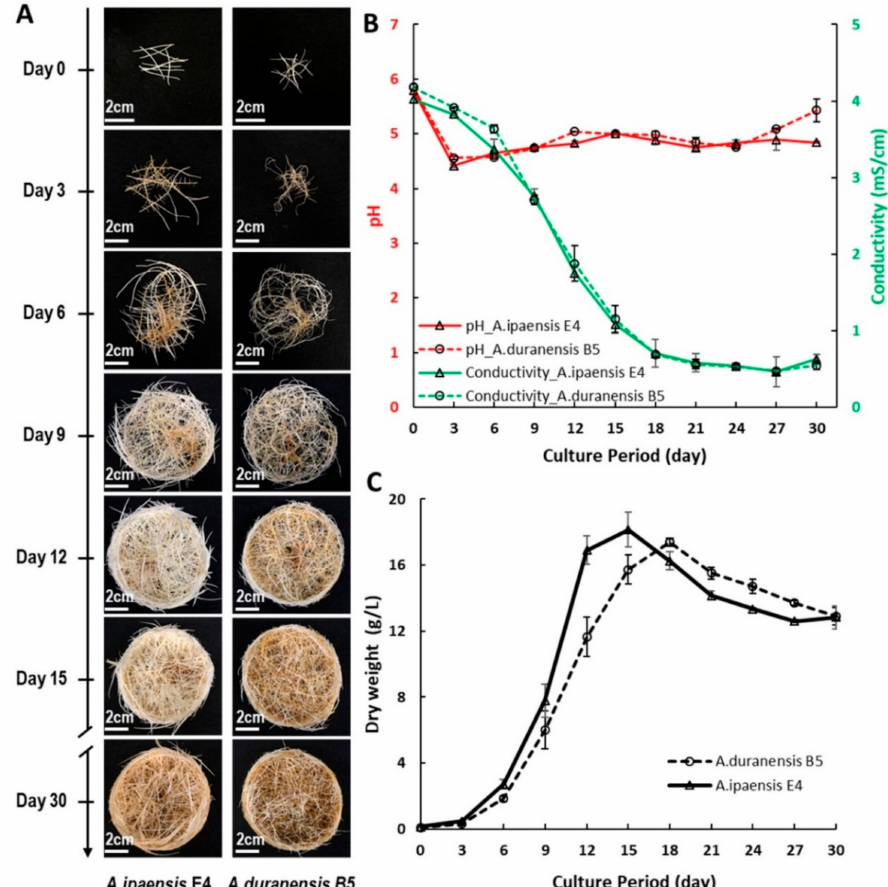
Figure 5. Growth of wild Arachis hairy root lines ( A. ipaensis line AiE4 and A. duranensis line AdB5). ( A ) Phenotype of the hairy root during the 30-day culture period. Pictures are representative of triplicate cultures. ( B ) Medium pH (red) and conductivity (green) at di ff erent stages of growth. ( C ) Growth curve of the hairy roots. Values represent the average of three independent flasks. Error bars represent standard